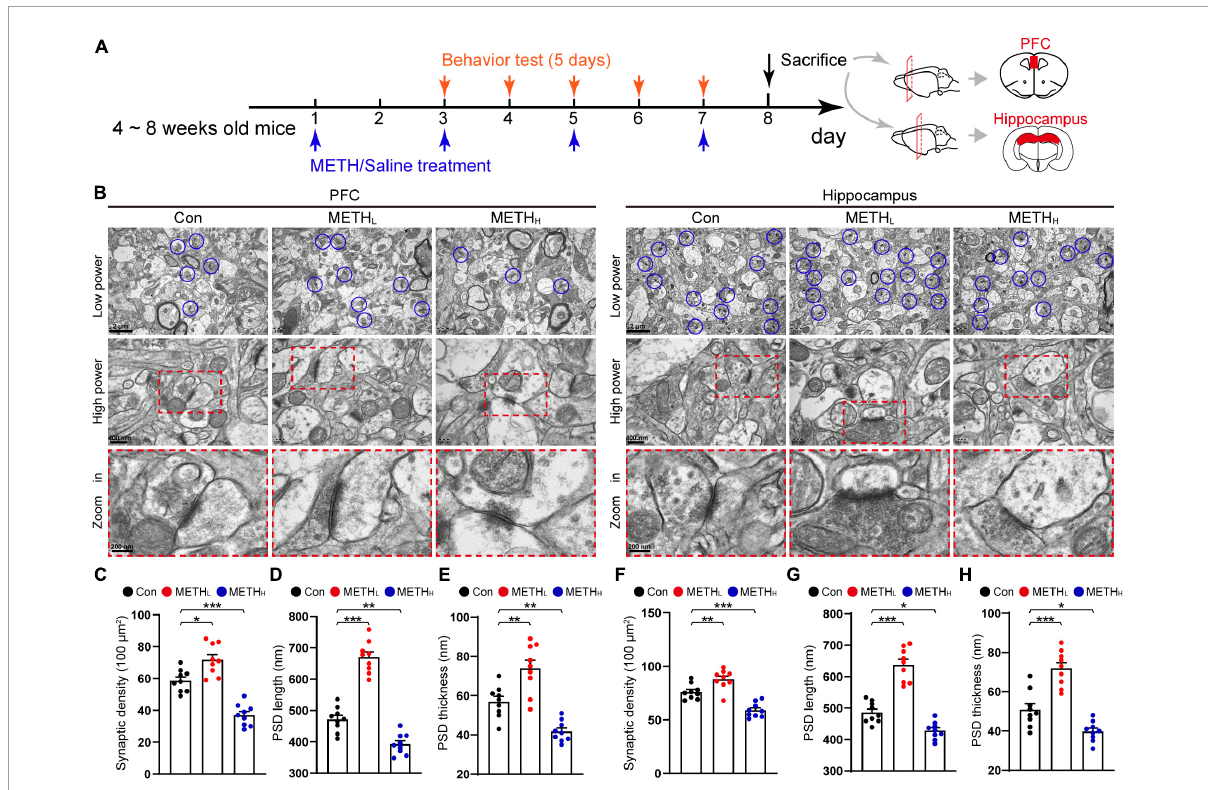
FIGURE1 Low and high dose methamphetamine (METH) modulate ultrastructure and density of synapse in cortex and hippocampus. (A) Experimental protocol. (B) Representative electron micrographs of synapses in cortex and hippocampus of Con, METH L and METH H mice groups. Blue circles indicate synapses. (C) Quantification of synaptic density in cortex. One-way ANOVA, F (2, 26) = 43.964, p < 0.001. (D) Quantification of PSD length in cortex. One-way ANOVA, F (2, 26) = 105.581, p < 0.001. (E) Quantification of PSD thickness in cortex. One-way ANOVA, F (2, 26) = 29.393, p < 0.001. (F) Quantification of synaptic density in hippocampus. One-way ANOVA, F (2, 26) = 32.33, p < 0.001. (G) Quantification of PSD length in hippocampus. One-way ANOVA, F (2, 26) = 68.342, p < 0.001. (H) Quantification of PSD thickness in hippocampus. One-way ANOVA, F (2, 26) = 37.364, p < 0.001. n = 9 slices, 3 slices per mouse. * p < 0.05, ** p < 0.01, *** p < 0.001 by one-way ANOVA and Dunnett’s post hoc